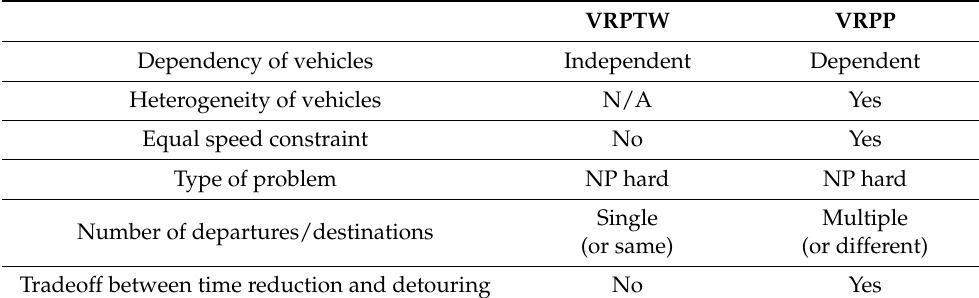
Table 2. Comparison between VRPTW and VRPP. VRPTW VRPP Dependency of vehicles Independent Dependent Heterogeneity of vehicles N/A Yes Equal speed constraint No Yes Type of problem NP hard NP hard Single Multiple (or same) (or different)